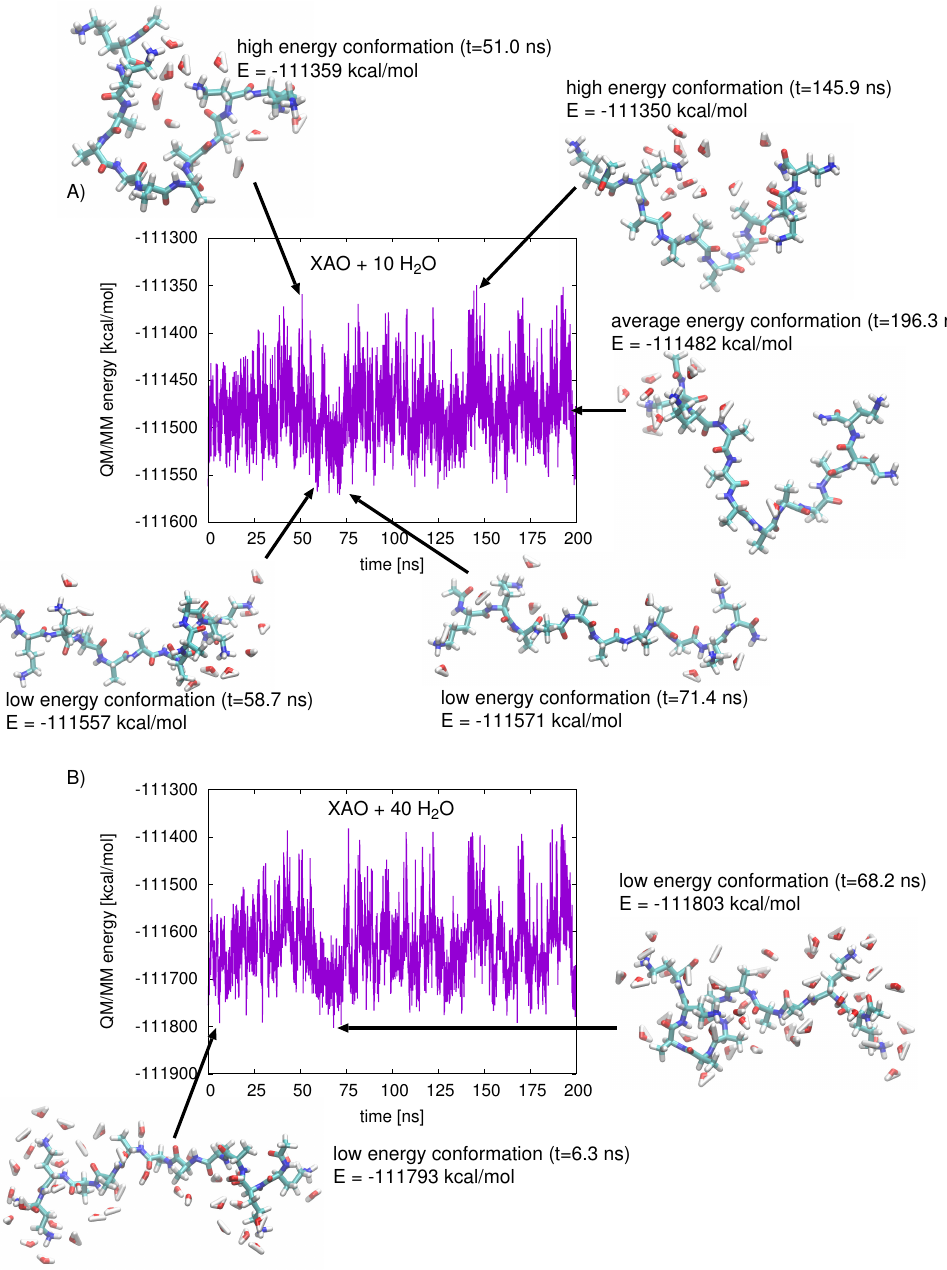
Figure 4. ( A ) the QM/MM energy of XAO and ten closest water molecules is plotted for snapshots taken from production data collected over 200 ns of MD. The geometries of XAO and 10 closest water molecules corresponding to high energy, average energy, and low energy states are shown; the lowest-energy conformation (t = 71.4 ns) shows maximum peptide extension; ( B ) the QM/MM energy of XAO and 40 closest water molecules is plotted for snapshots from production data collected over 200 ns of MD; two representative low-energy geometries are